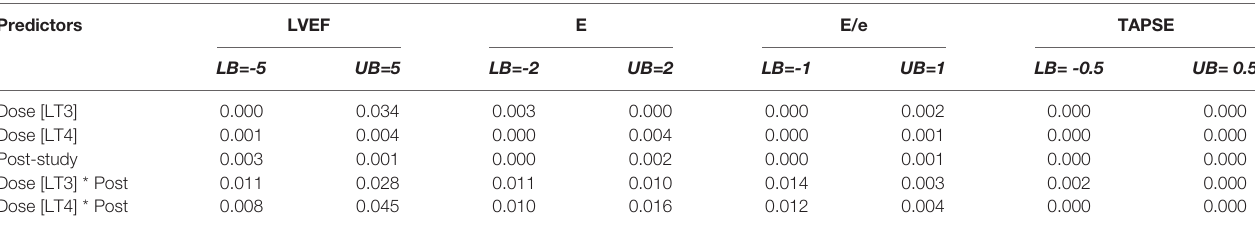
TABLE 7 | Equivalence tests (TOST procedure) of the estimated effect sizes in Table 5 .